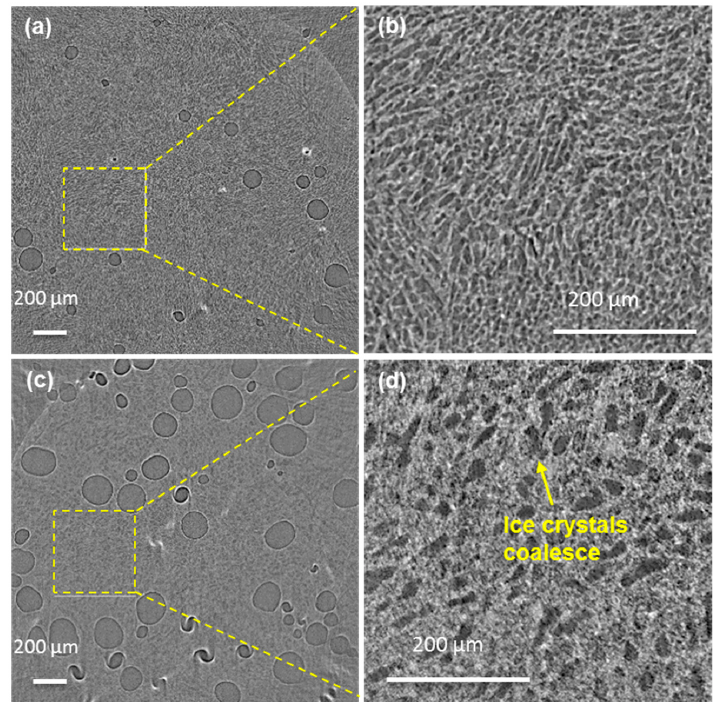
Figure 4. The reconstructed 2D tomographic slices. ( a , b ) Following fast cooling (FC) to 250 K. ( c , d ) Following heating to 266.8 K and holding for 10 min. In (a), the large circular dark areas with thin brighter boundaries are air cells and the matrix comprises of a dark contrast for the ice crystals and a brighter contrast for the unfrozen material. Zoom-ins of the areas highlighted by yellow squares in ( a , c ) are shown in ( b , d ) respectively.